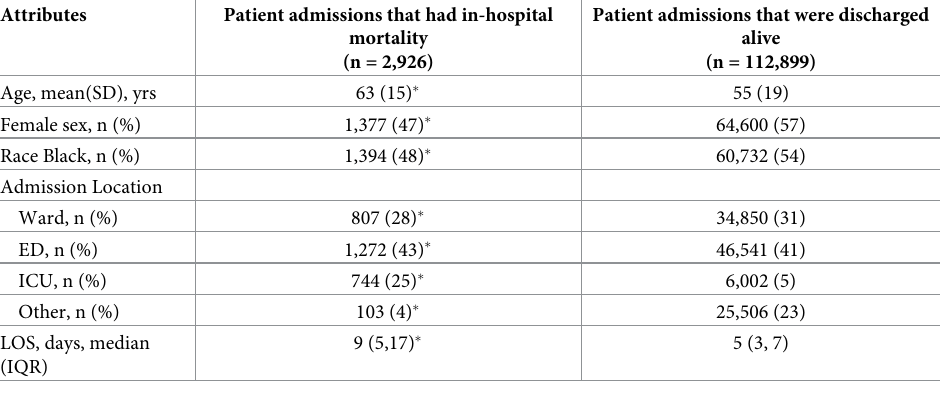
Table 1. Comparison of characteristics between patients who experienced in-hospital mortality and those who were discharged alive.